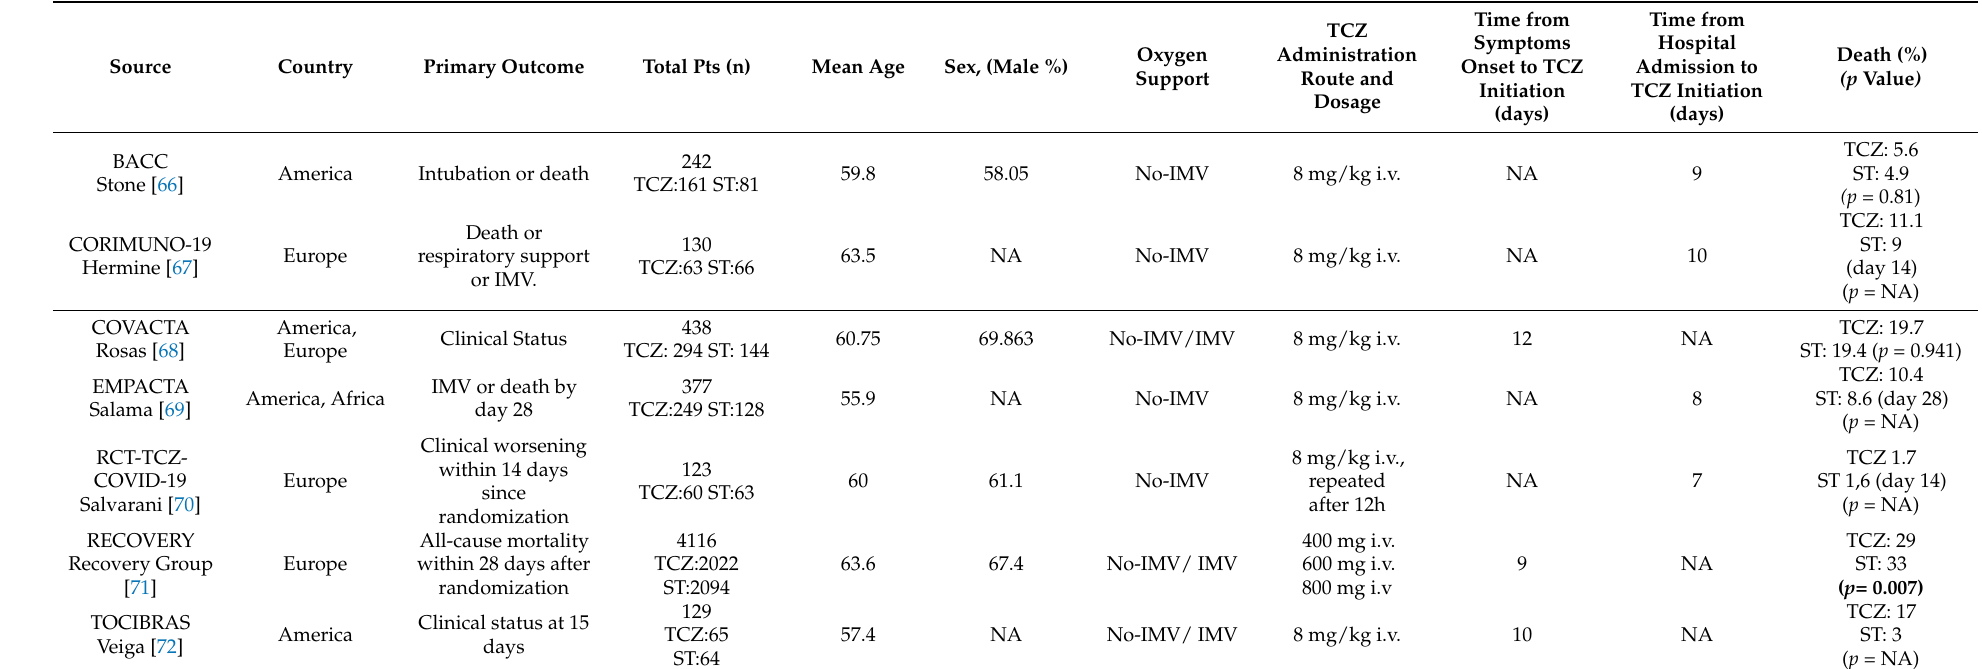
Table 3. Characteristics of the RCTs introduced in the